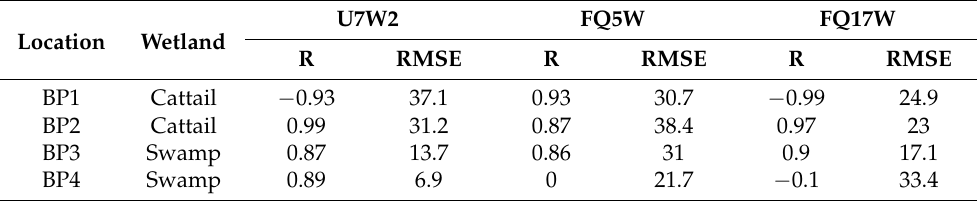
Table 10. Comparison of InSAR results and field water level measurement in Bay of Quinte in 2018 (HH polarization). Location